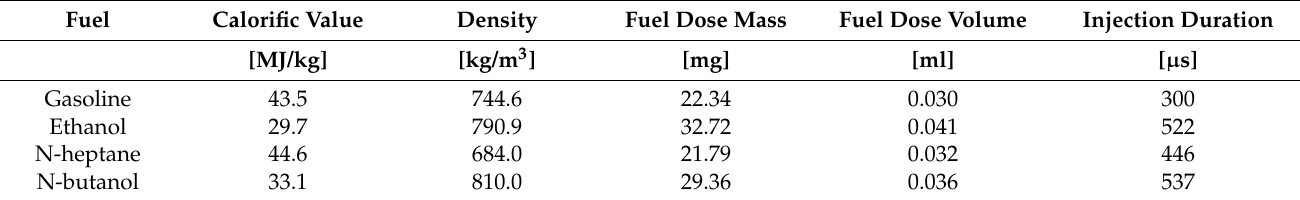
Table 5. Doses and injection times for fuels delivered during one research process by one injector.